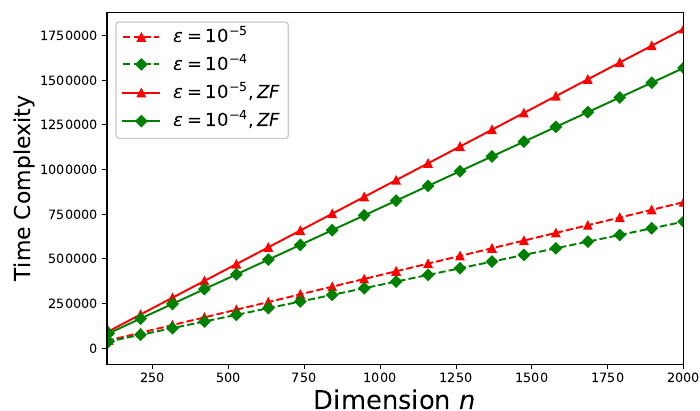
Figure 9. Time-complexity versus n for an arbitrary inconsistent system ( k = 100, m = 1.25 n ). The curves denoted by “ZF” illustrate the theoretical time-complexity error-bounds for solving the original system involving the matrix V without factorization (theoretical results from [46]).